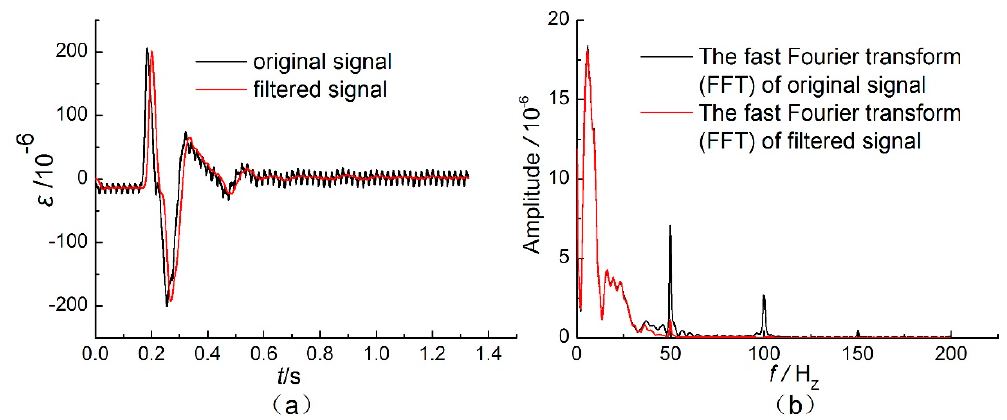
Figure 11. Typical strain waveform before and after filtering: ( a ) The original and filtered signals; ( b ) the fast Fourier transform (FFT) spectra of the original and filtered signals.